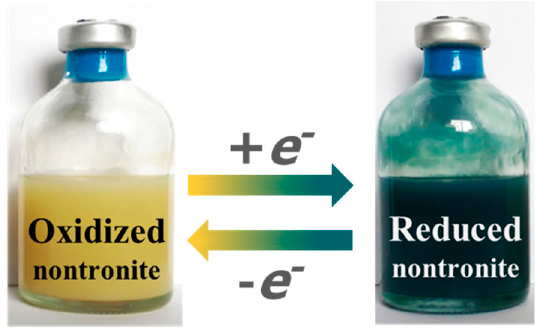
Figure 1. Oxidized and citrate-bicarbonate-dithionite (CBD)-reduced NAu-1 nontronite.